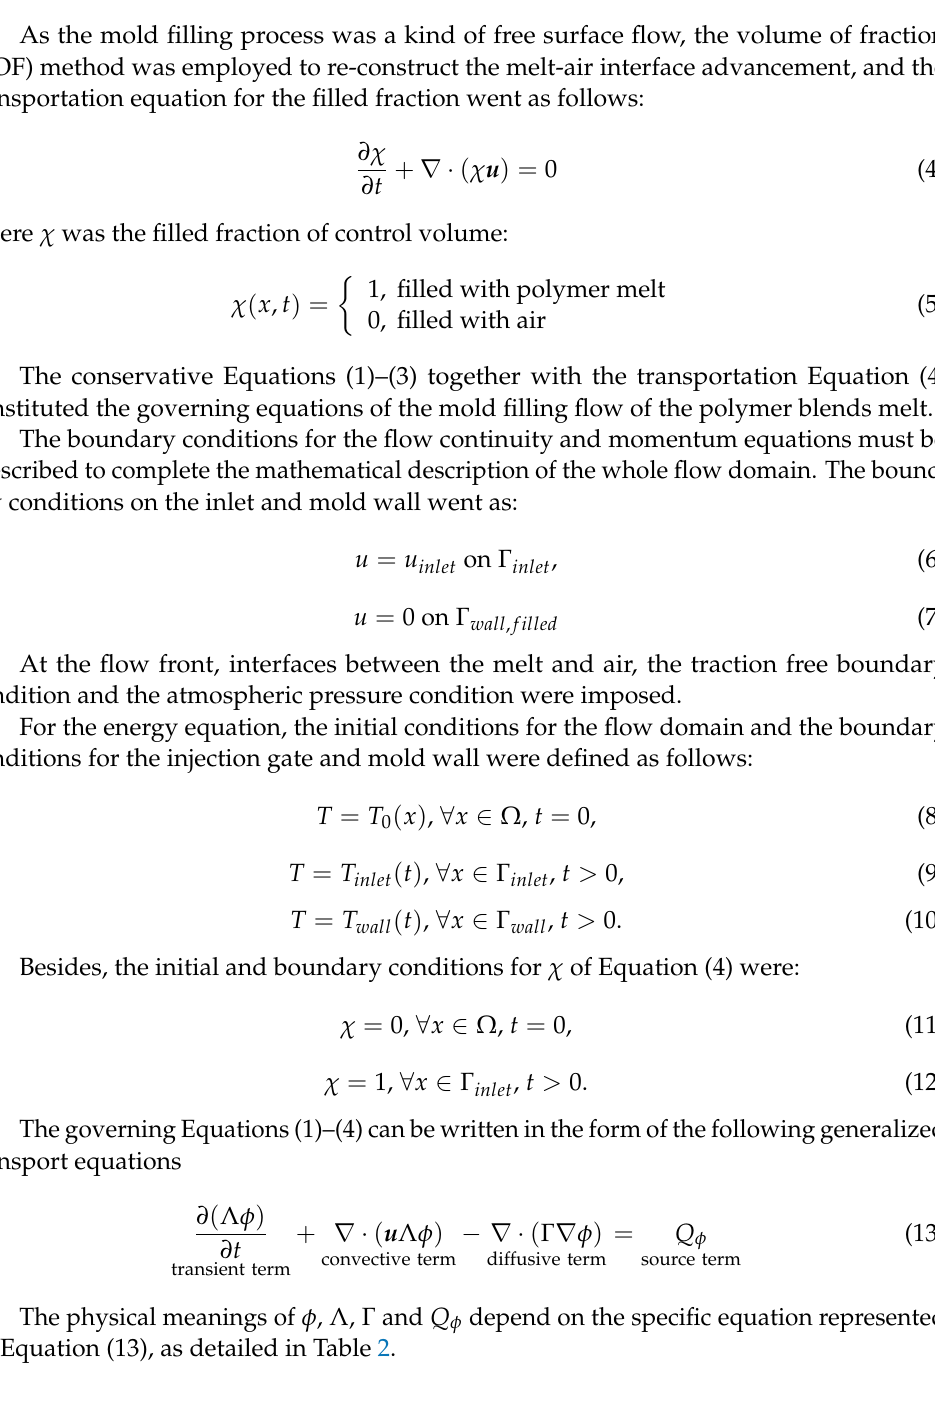
Table 1. Variables of the Governing Equations. Variable Meaning Variable Meaning u velocity c p specific heat P pressure k thermal conductivity T temperature µ viscosity time density . Φ heat gravity